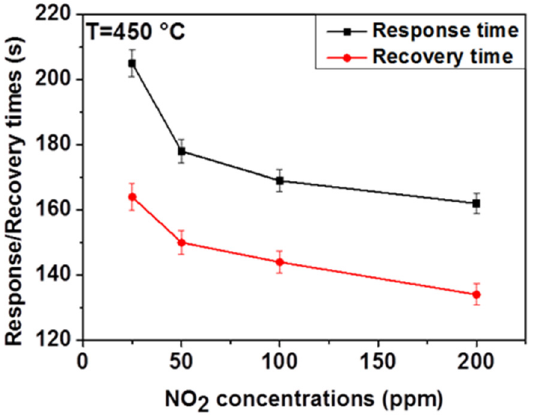
Figure 5. Relationship between NO 2 concentrations and the response and the recovery time for the ZnO thin film at 450 °C in dry air.